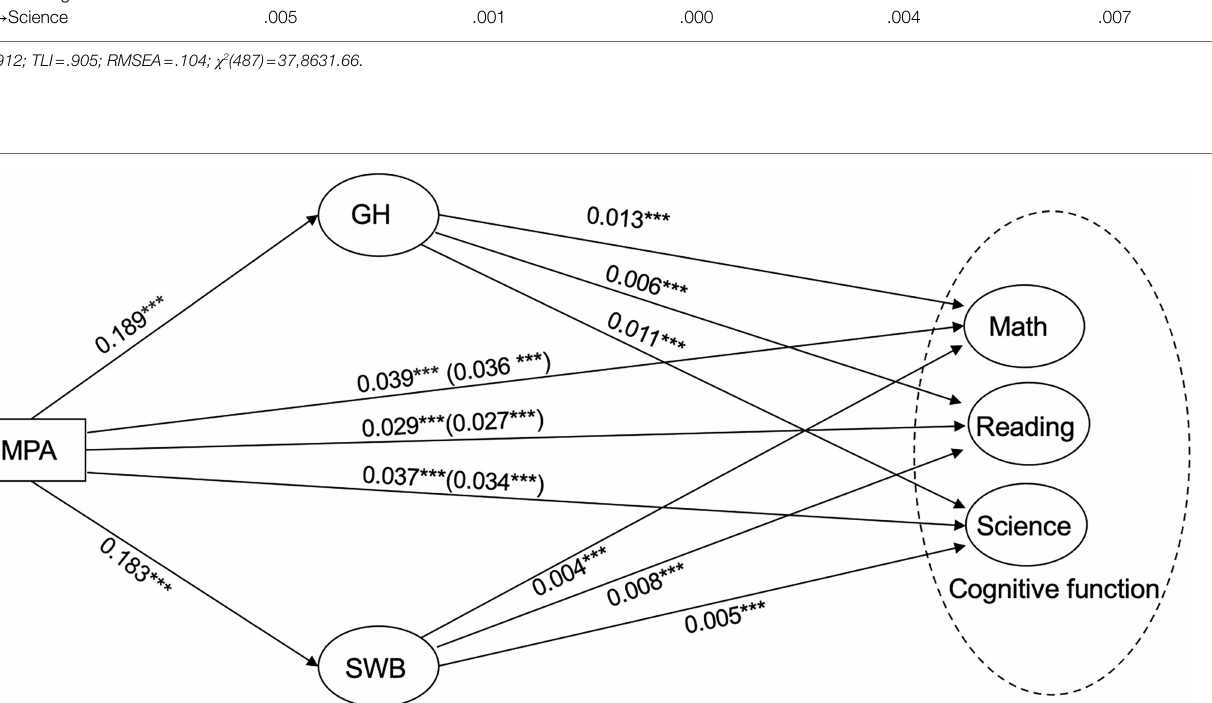
deviations among low-to-middle income countries. Based on these prior estimates, conservative calculations indicated that our findings of .036 standard deviations increase in student